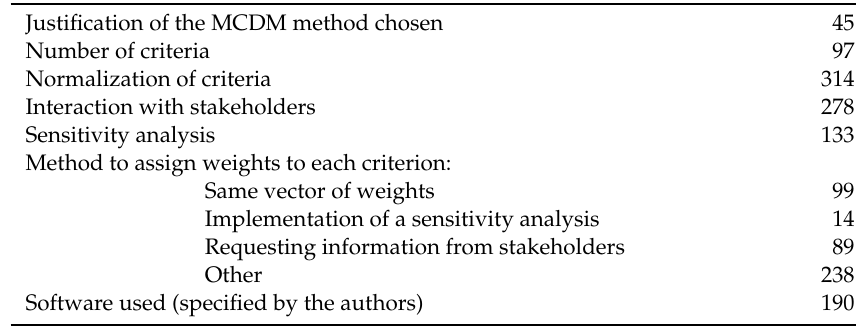
Table 3. Techniques used with MCDM.